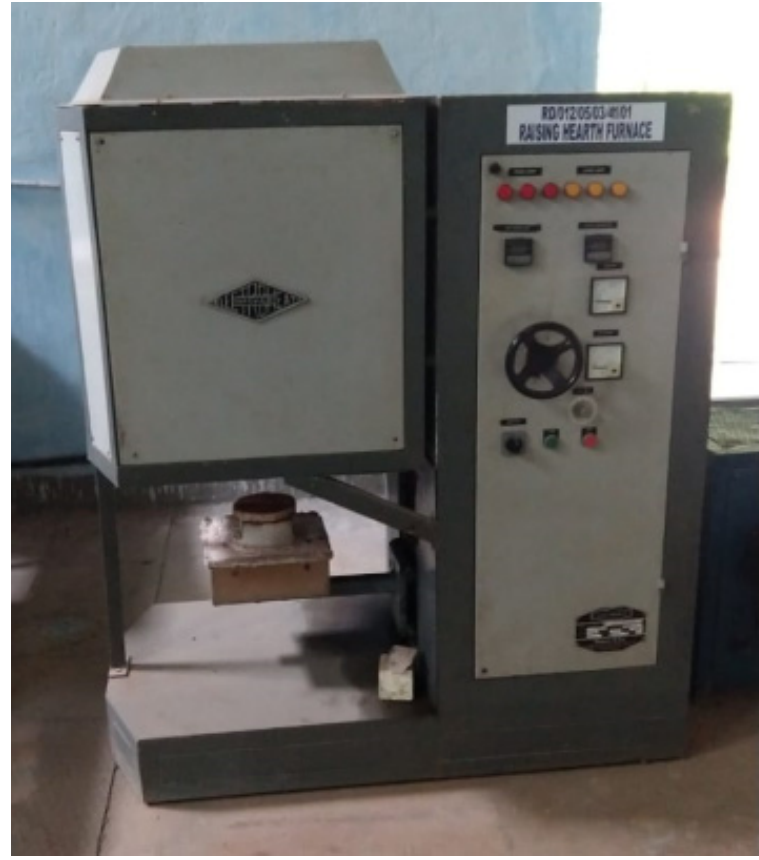
Figure 1. Raising Hearth Furnace